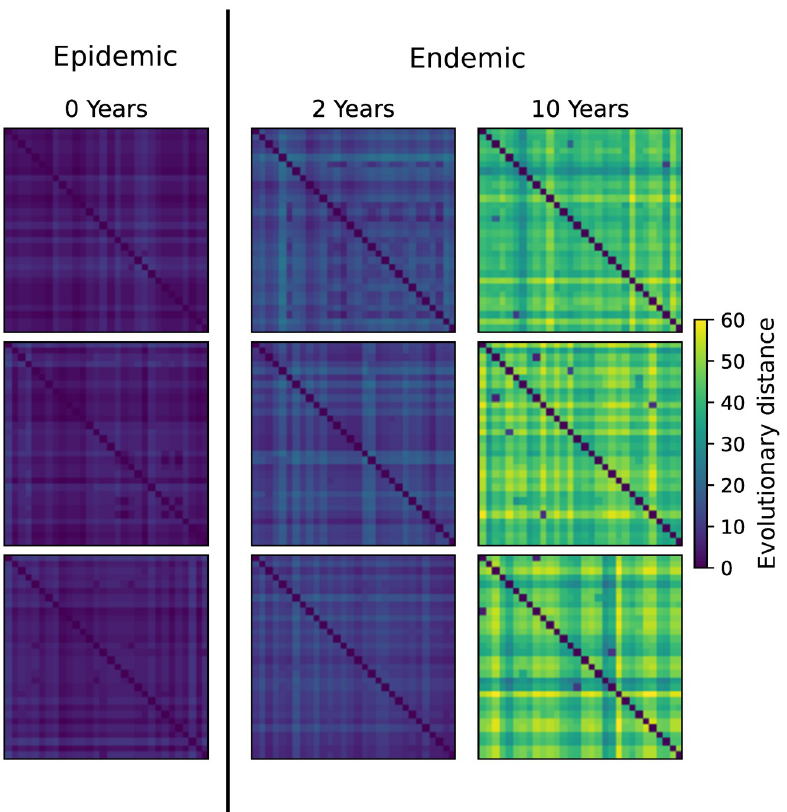
Fig 2. A collection of example images used for training from each sampling year. Each pictured training example was generated with R 0 > 4. Three example images are shown for each sampling time (Fig 1A).